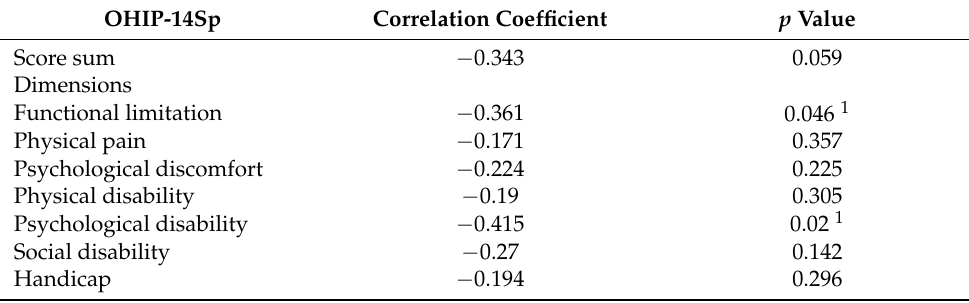
Table 5. Correlation between health status measure with ES-VAS and OHIP-14Sp